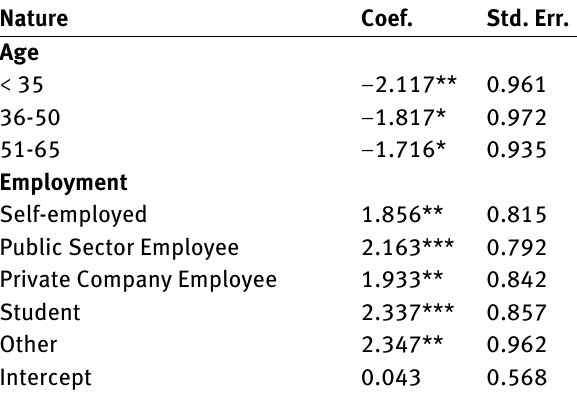
Table 17: Coeflcients of the model for nature sounds Nature